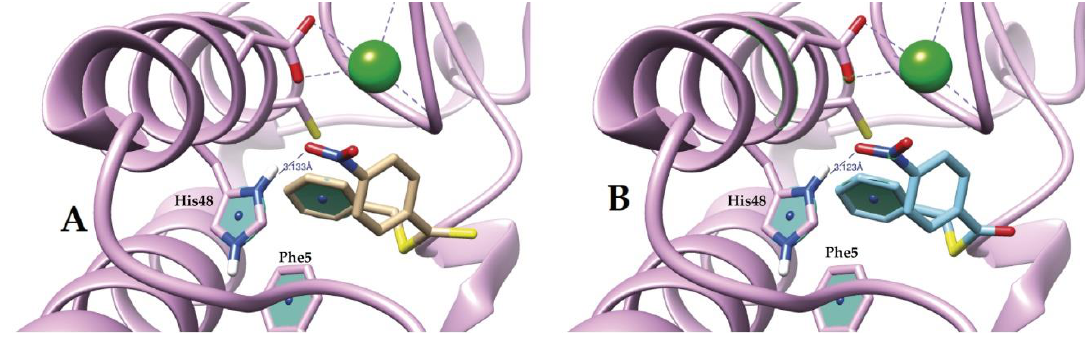
Figure 3. Docking conformations with the highest affinities for compounds I (red) and II (yellow).